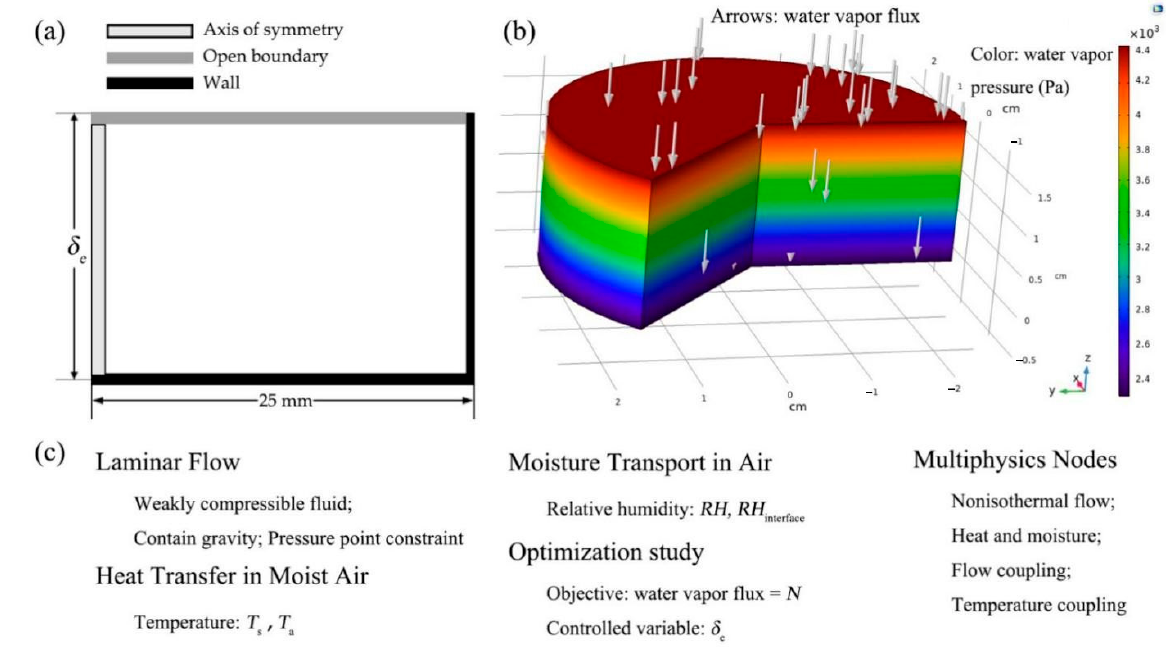
Figure 5. ( a ) 2D and ( b ) 3D schematic of the axisymmetric computational domain used in the model and ( c ) settings of component node. Optimization study was conducted to calculate the thickness δ e .